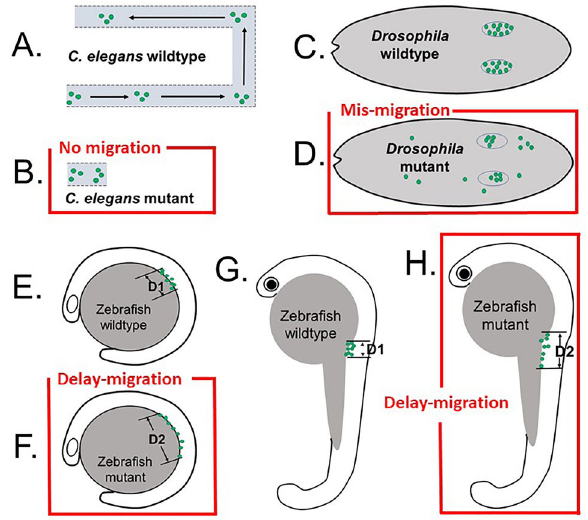
Figure 7. Schematic drawings show difference in the defects of germ cell migration in Adamts9 or its ortholog knockouts in C. elegans, Drosophila , and zebrafish models. Green dots denote primordial germ cells (PGC). Only the posterior gonad arm is shown for C. elegans . ( A ) PGCs migrate in wildtype C elegans , ( B ) no migration occurs in gon-1 mutant (modified from Blelloch and Kimble 14,15 ). ( C ) PGCs migrate